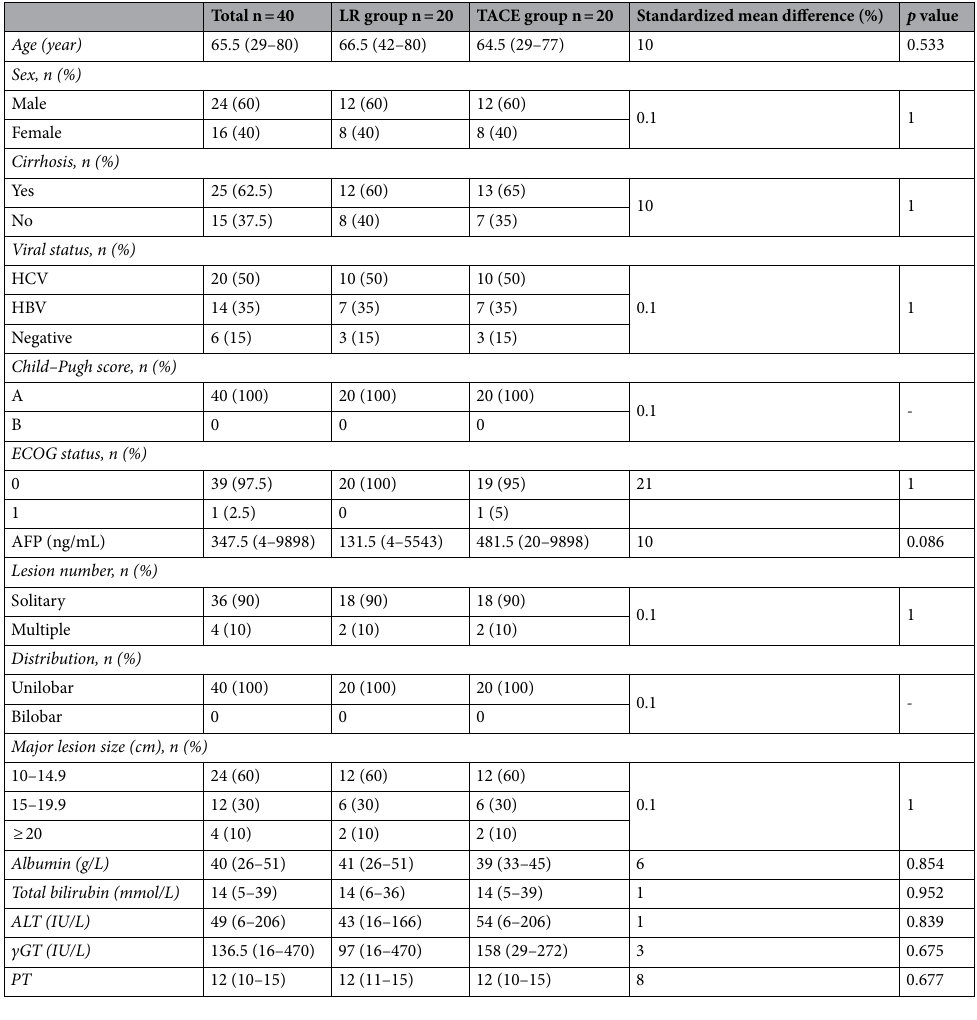
Table 2. Demographic and clinical features after propensity score matching. Values are expressed as median (range) unless indicated otherwise. LR liver resection, TACE transarterial chemoembolization, HCV hepatitis C virus, HBV hepatitis B virus, ECOG Eastern Cooperative Oncology Group, AFP alfa-feto protein, ALT alanine transaminase, γGT γ glutamil transferase, PT prothrombin time.